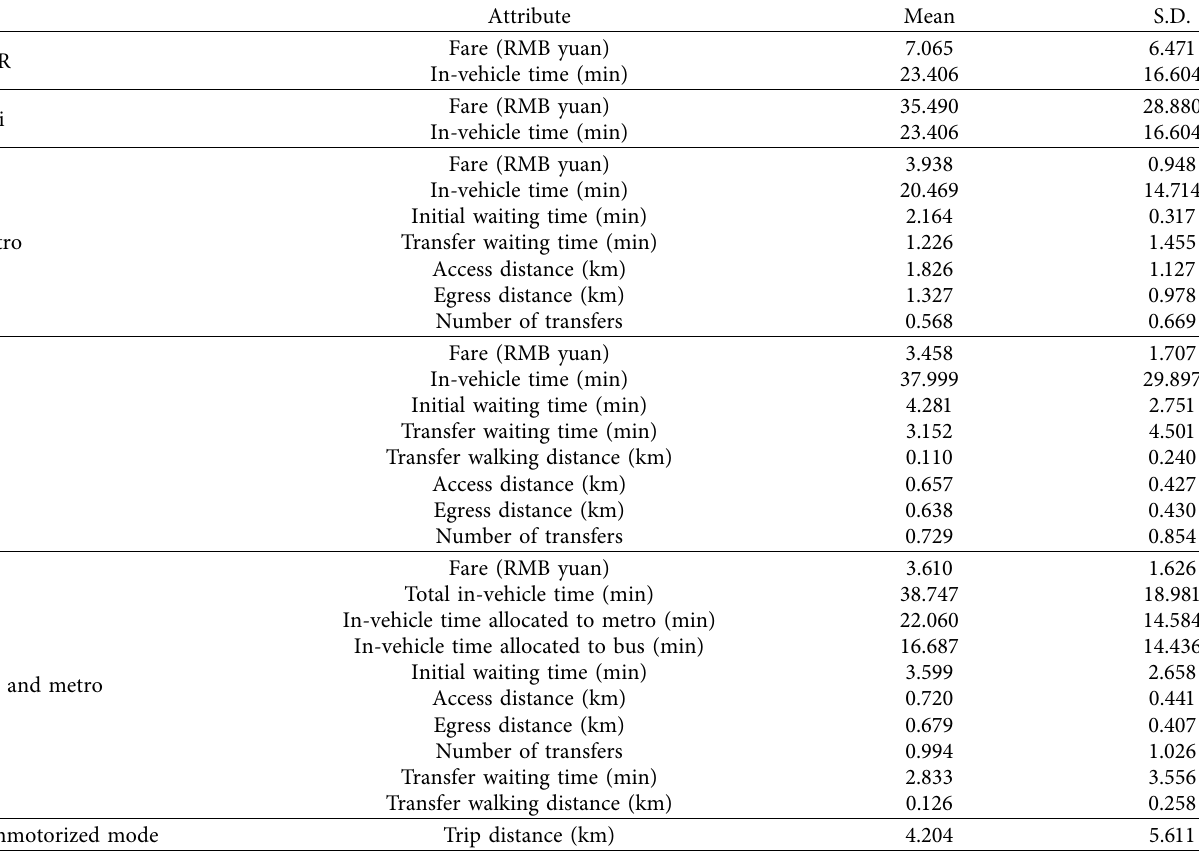
Table 5: Descriptive statistics of LOS (level-of-service) attributes.